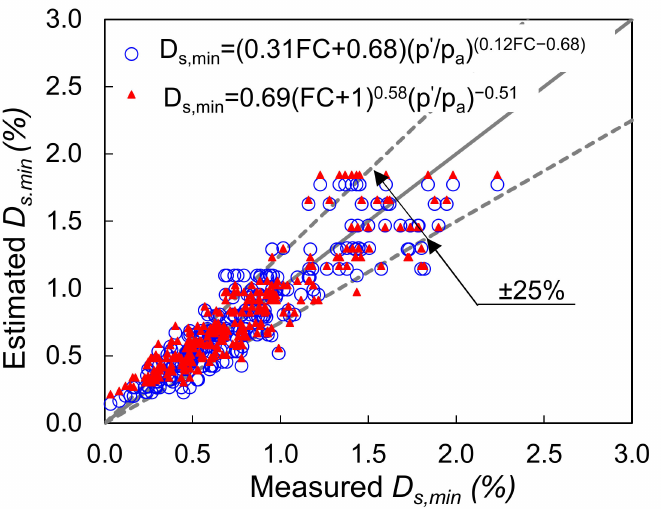
Figure 12. Curve-fitting of small-strain damping ratio against fiber content and normalized effec- tive pressure.